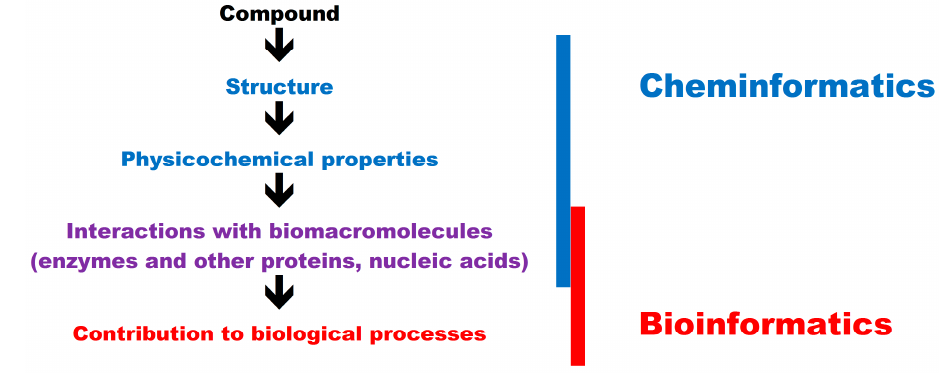
Figure 1. Chemical and biological approaches to in silico research into small molecules.